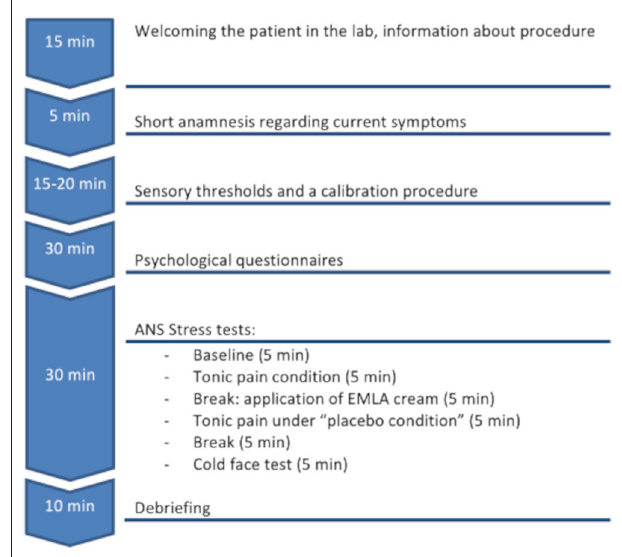
FIGURE 1 | Time lapse of the T1 and T2 experimental sessions.